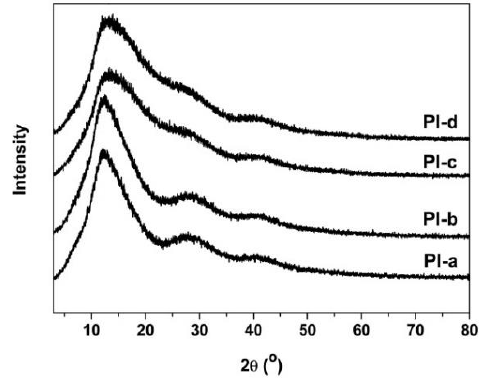
Figure 4. XRD patterns of black PI films.